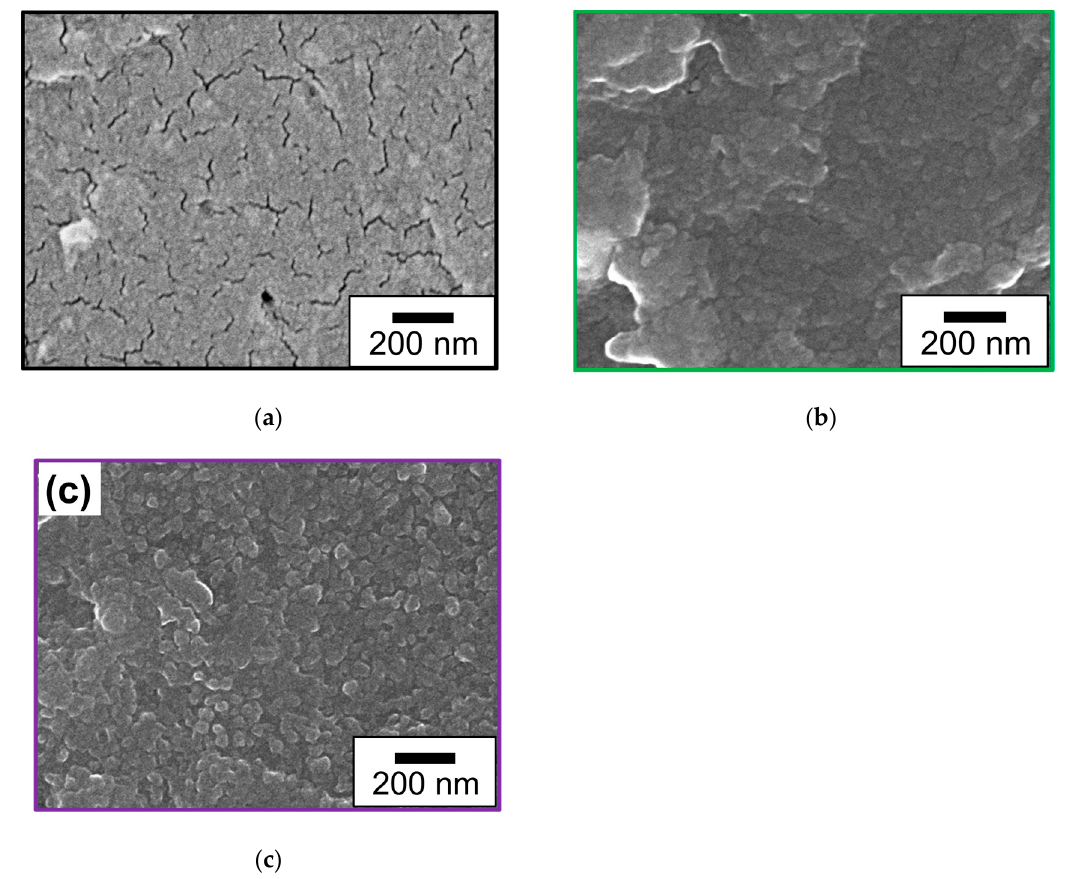
Figure 9. Scanning electron microscope (SEM) images of the surface of an ABS substrate before and after PDA coating with or without plasma treatment: ( a ) ABS-untreated, ( b ) ABS-PDA(24h), and ( c ) Pt/ABS-plasma-PDA(24h).